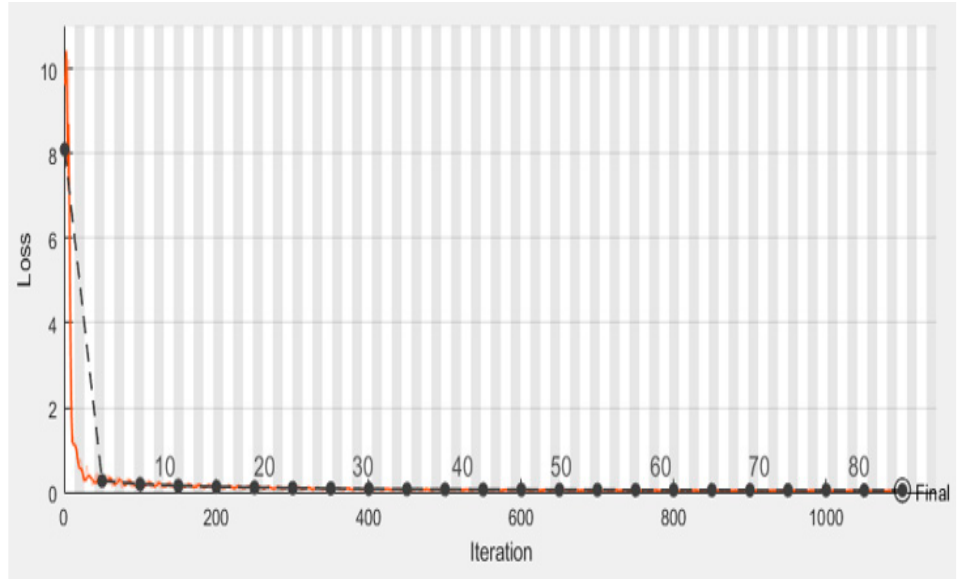
Figure 10. Validation accuracy.